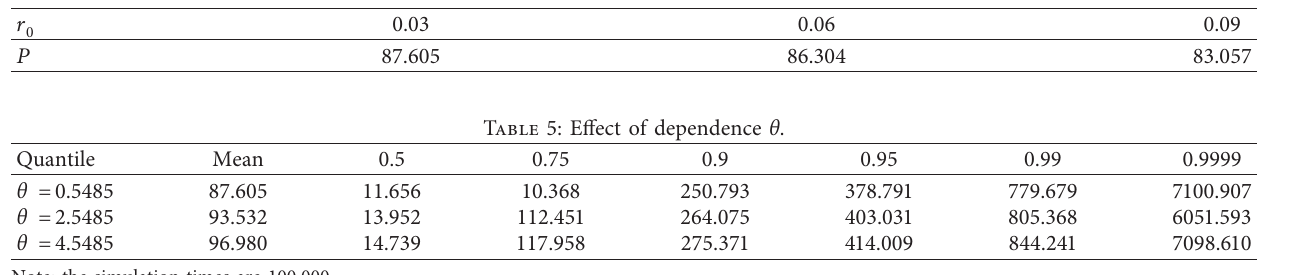
Table 4: Effect of initial interest rate value.